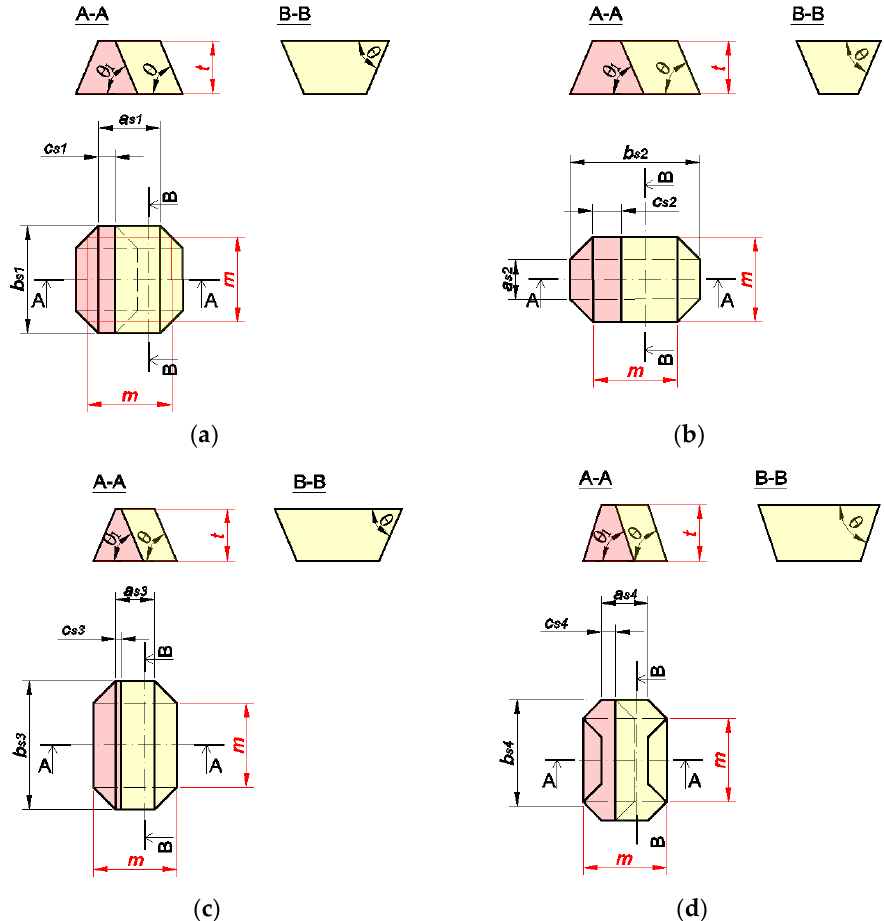
Figure 27. The order of entering parts of the keystone into the square vault.